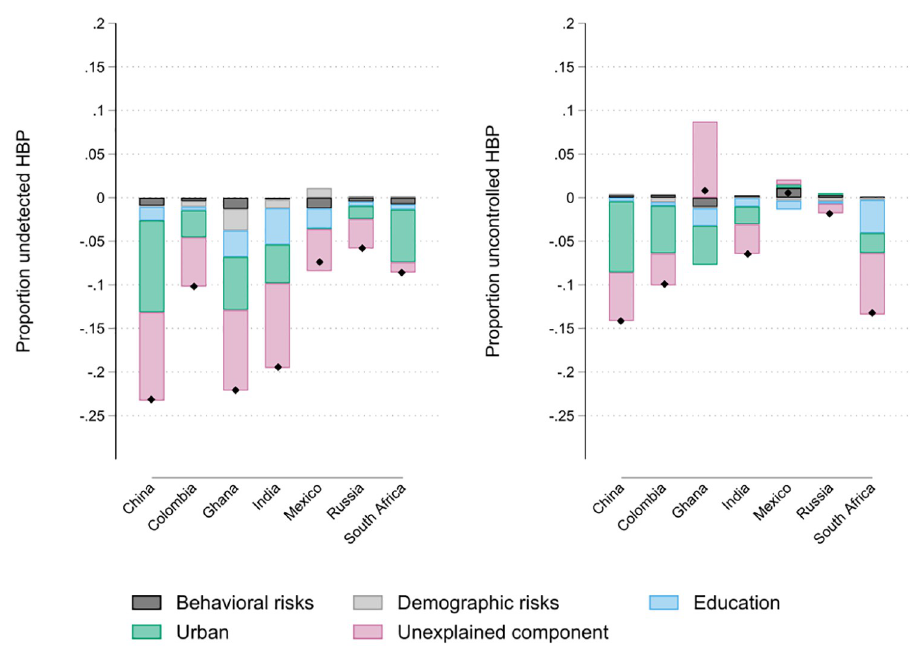
Fig 4. Contribution to gap in undetected and uncontrolled HBP conditional on being aware o hypertension. Notes : Contribution of covariate groups to the gap on undetected and uncotrolled HBP between individuals in the lowest wealth quintile agains the other quintiles. These numbers are computed with the Blinder-Oaxaca decomposition after linear probability models.